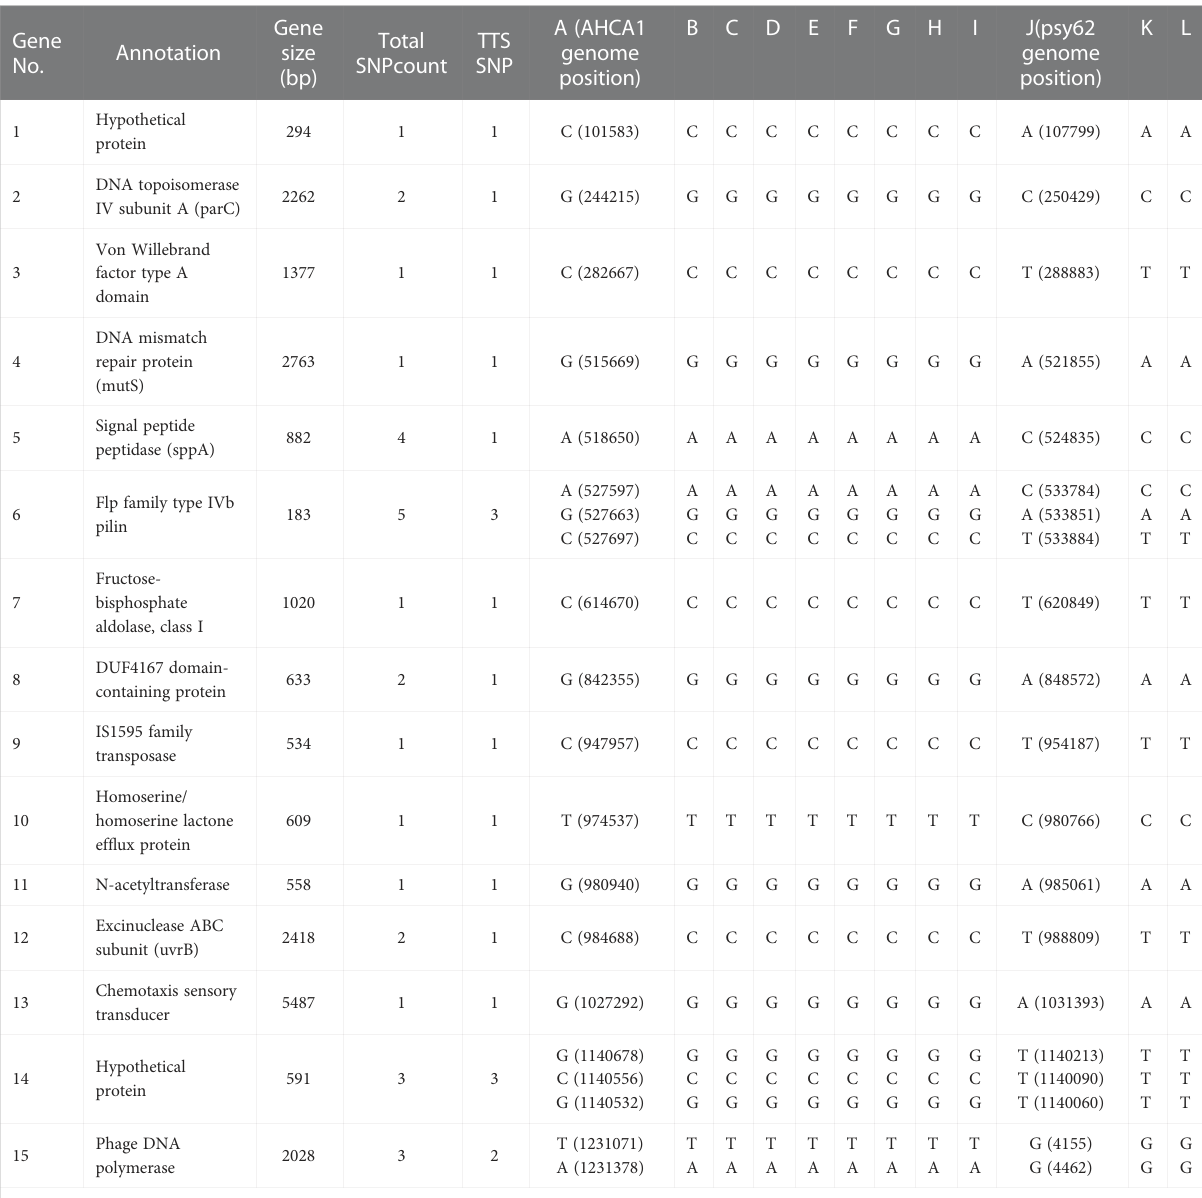
TABLE 4 List of genes with single nucleotide polymorphisms (SNPs) supporting the terL typing system (TTS) based on partial least squares discriminant analysis (sPLS-DA) on 12 selected genomes sequences of “ Candidatus Liberibacter asiaticus ” strains (column A to L a ).